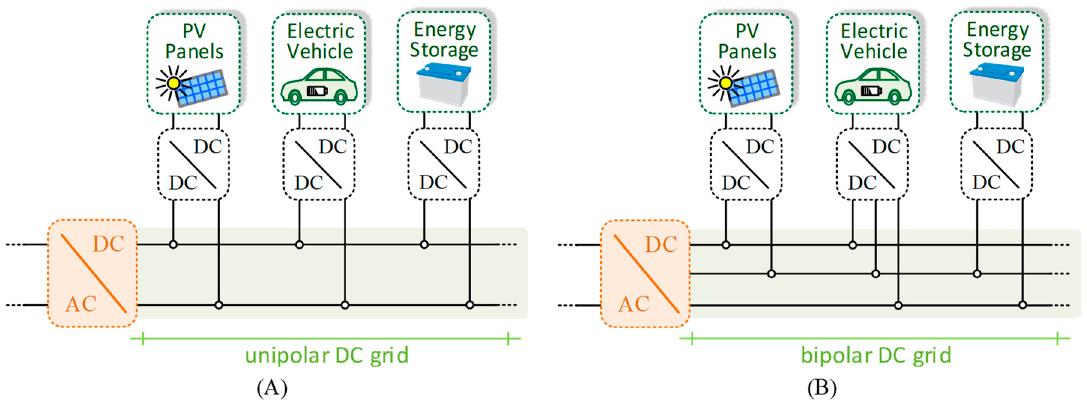
Figure 2. Possible configurations of DC grids based on: ( A ) Unipolar DC grid; ( B ) Bipolar DC